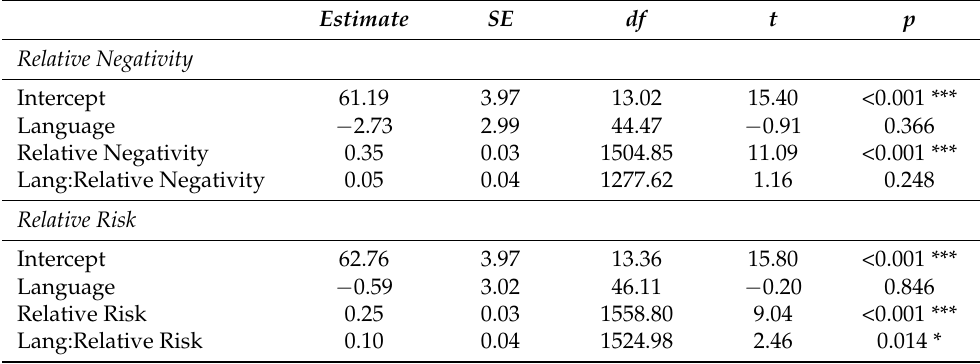
Table 3. Effects of Language and Relative Risk/Negativity on Willingness to Accept Preventative